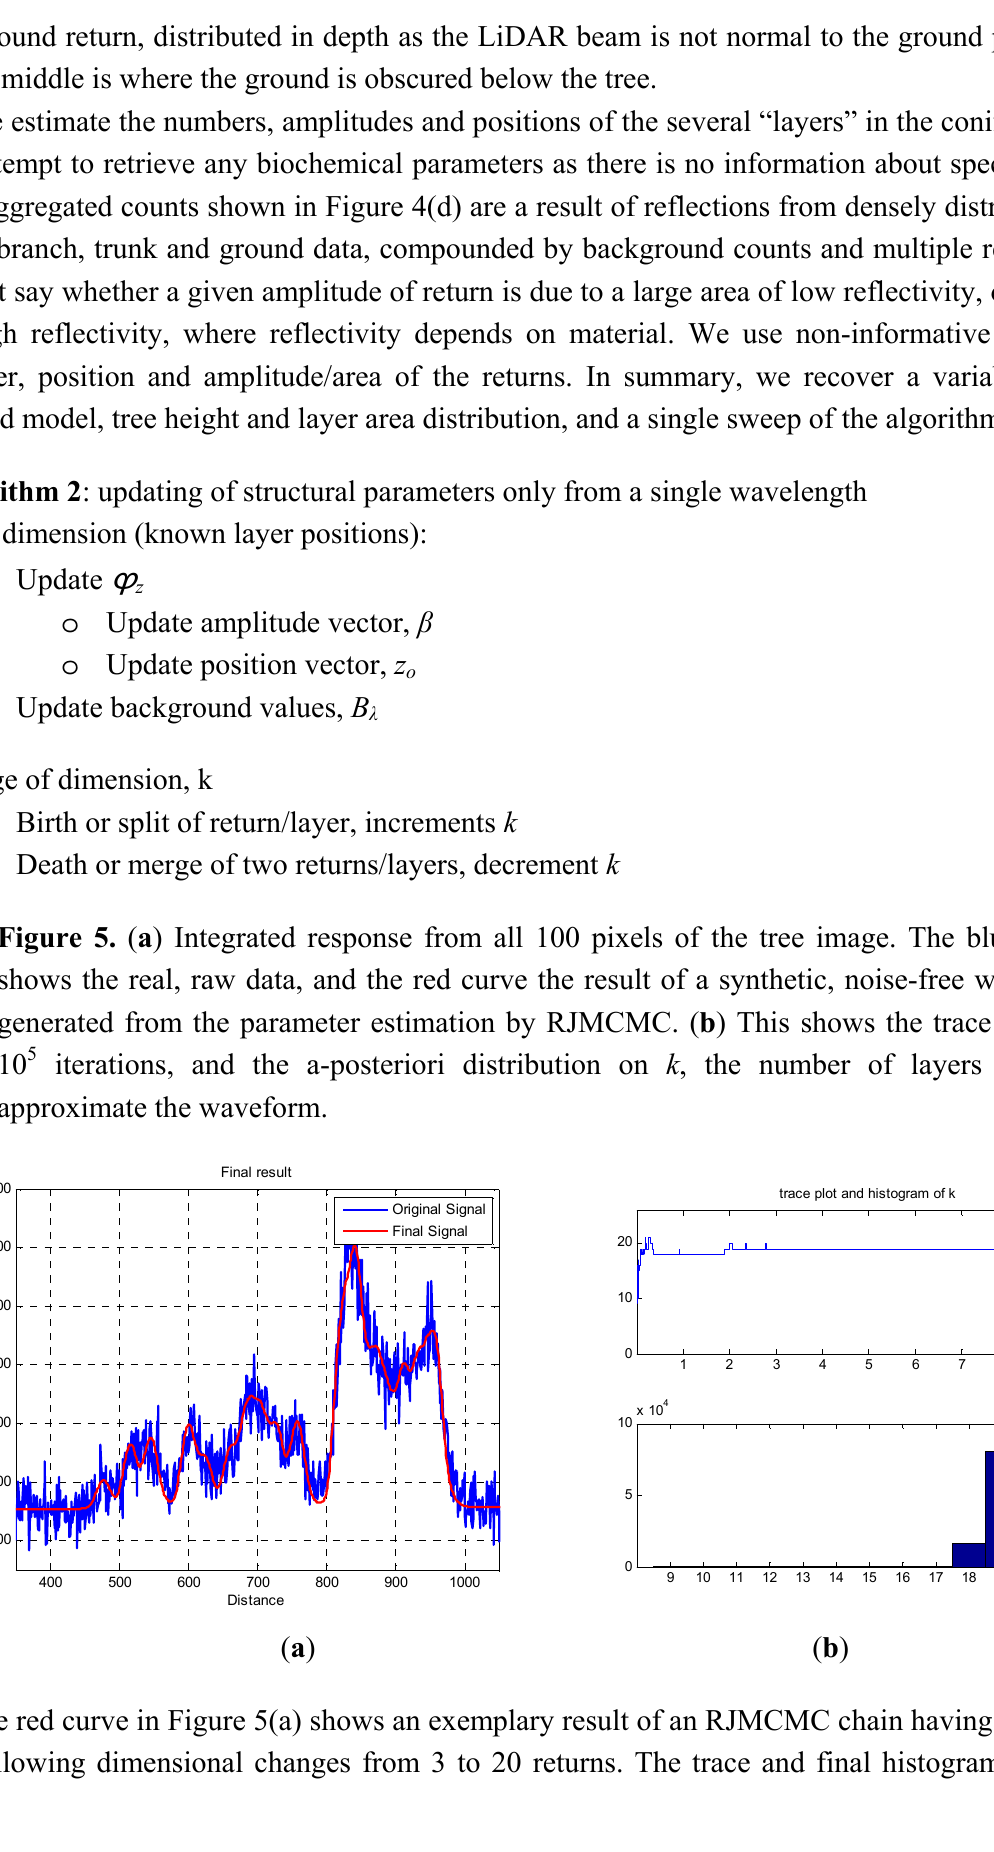
Algorithm 2 : updating of structural parameters only from a single wavelength Fixed dimension (known layer positions):